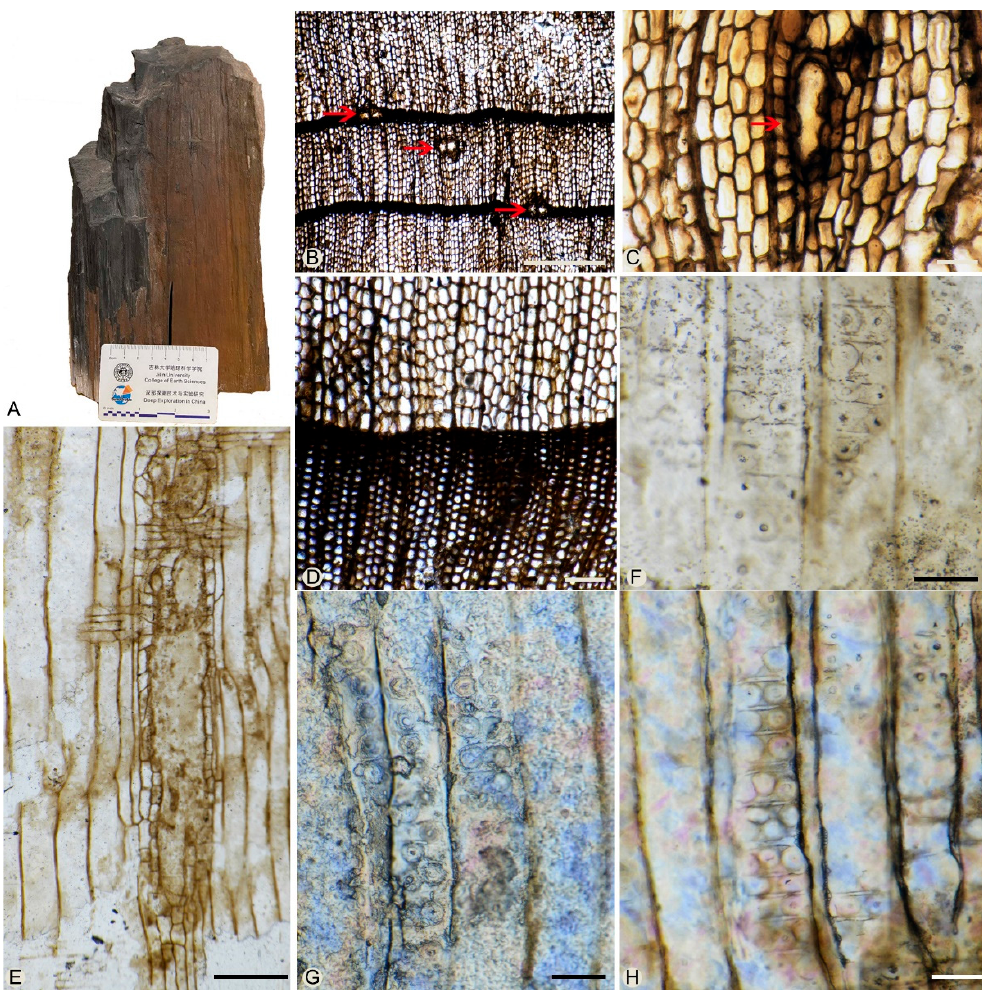
Figure 3. Keteleerioxylon changchunense Shi, Sun, Meng et Yu sp. nov. ( A ). General view of the specimen JLJY-02. ( B ). Transverse section showing the resin canals (red arrows) and growth ring boundaries. ( C ). Close-up of the resin canals (red arrow) . ( D ). Close-up of the growth ring boundary. ( E ). Radial section showing the vertical resin canal. ( F ). Radial section showing the biseriate pits on the radial walls of tracheids and the crassulae. ( G , H ). Radial section showing the opposite and alternate biseriate pits and triseriate pits and the crasulae on the radial walls of tracheids. Scale bar: A: the longer scale mark in the card is 1 cm; B = 1 mm; C, D, E = 200 μ m; F, G, H = 50 μ m.